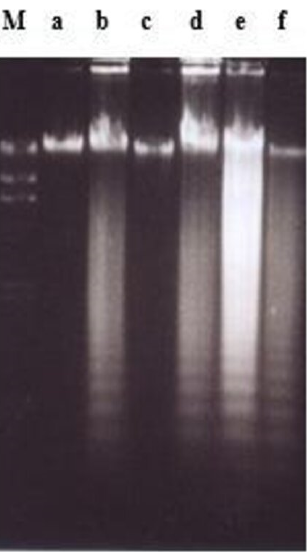
Figure 11. The involvement of RNA synthesis in damnacanthal-induced apoptosis in CEM-SS cells at 24 h. Actinomycin D failed to prevent apoptosis induced by 30 μg/mL of damnacanthal at 24 h. Lane a: control. Lane b: damnacanthal (30 μg/mL). Lane c: actinomycin D (10 μg/mL). Lane d: damnacanthal (30 μg/mL) + actinomycin D (10 μg/mL). Lane M: Marker (HindIII digest of lambda DNA).